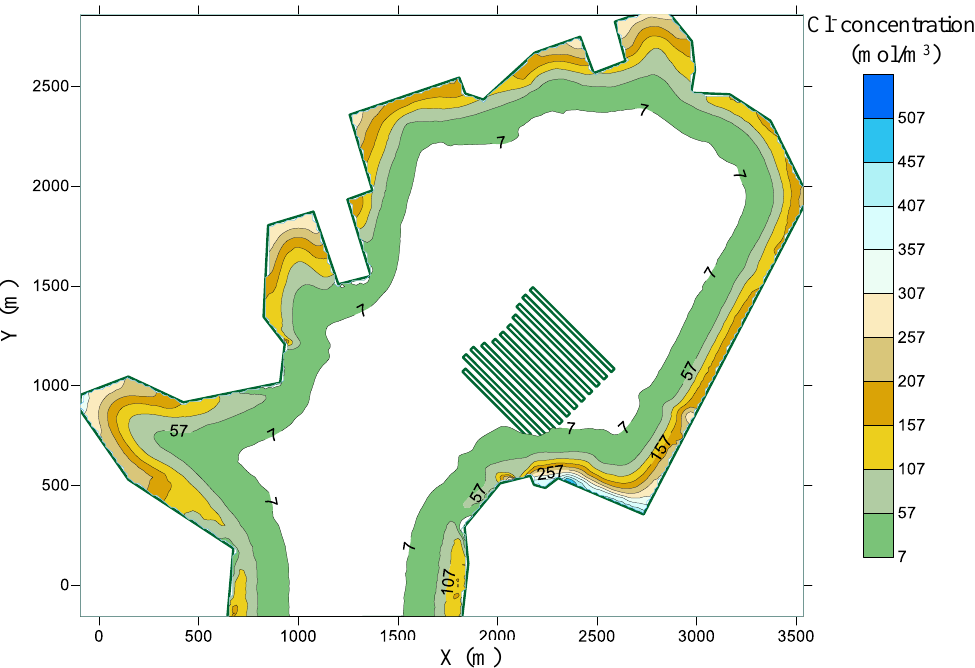
Figure 17. Cl − concentration contour at − 80 m elevation with groundwater injection in the curtain system after 50 years operation.